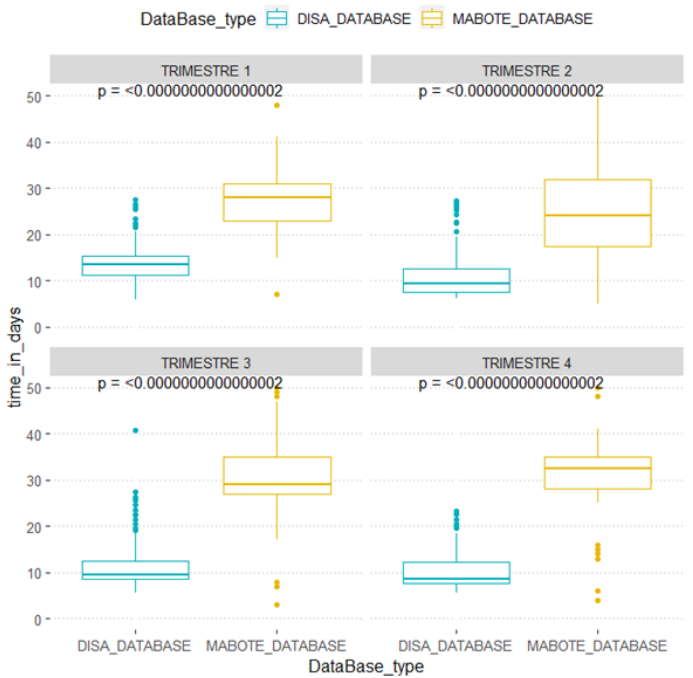
Figure 3. Turn the time over four quarters, from sampling to the availability of physical results, checked in laboratory journals.